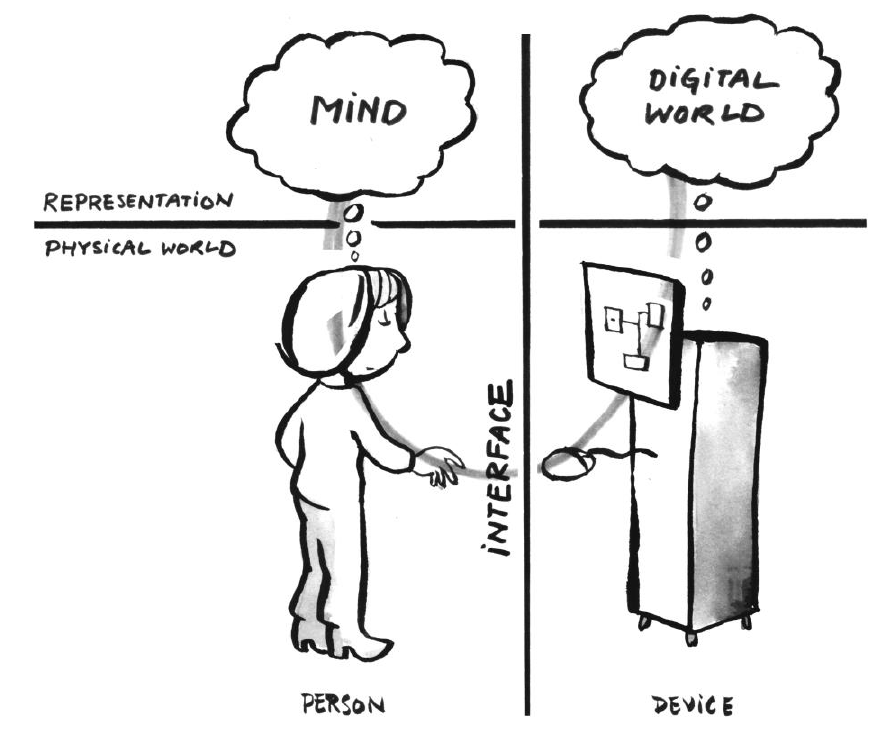
Figure 3. The human mind and the digital world of the computer consist of representations of the outside world. Information is exchanged through their interfaces. © Jelle van Dijk.